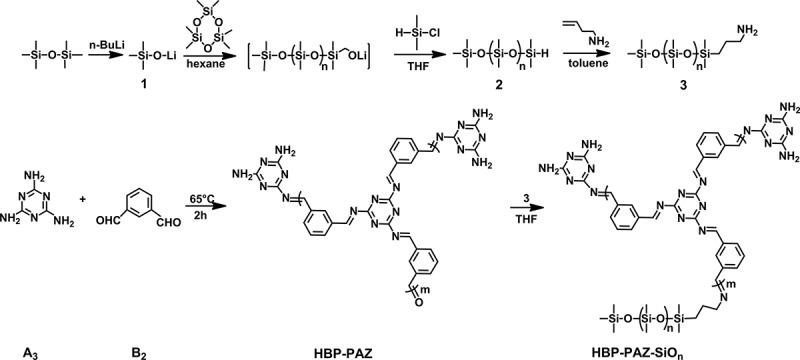
Synthesis of soluble oligosiloxane end capped hyperbranched polyazomethine HBP-PAZ-SiOn (n = 9,18 and 39).